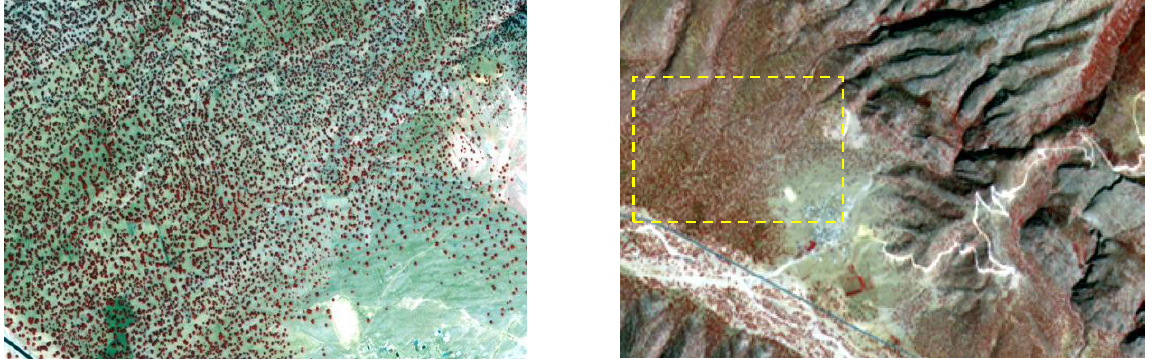
Figure 1. Illustration of images from ASTER (right image) yellow box and QuickBird (left image) showing study area of oak